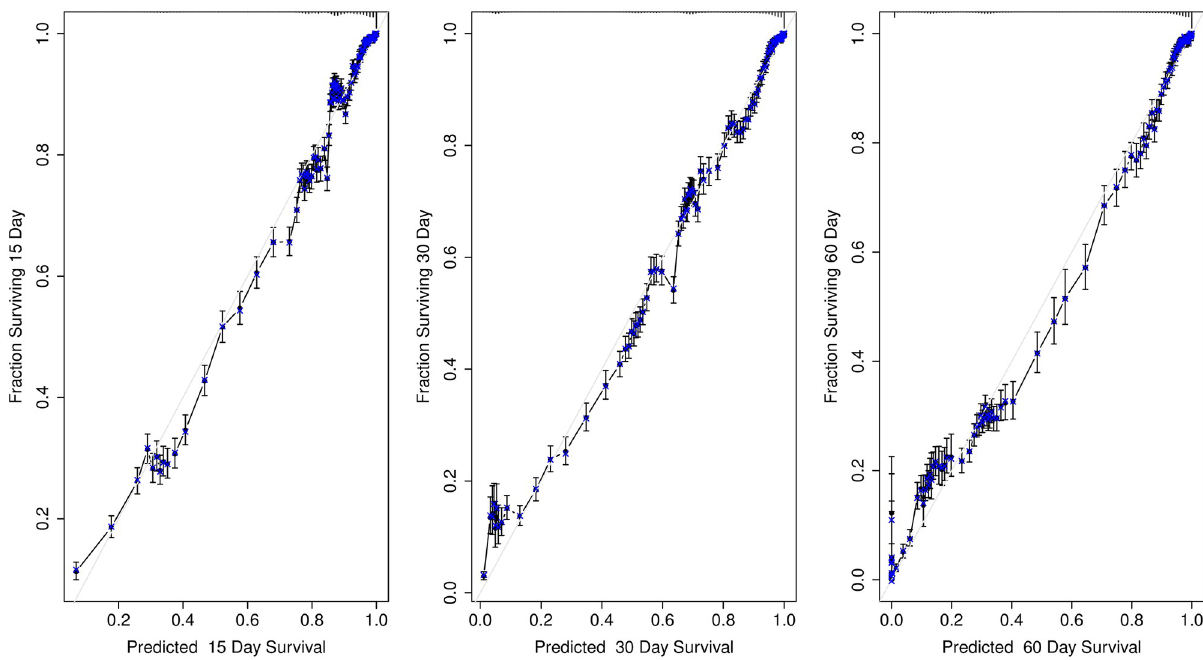
Fig 5. Calibration results. The plot shows internal model calibration for predictions at 15, 30 and 60 days after COVID-19